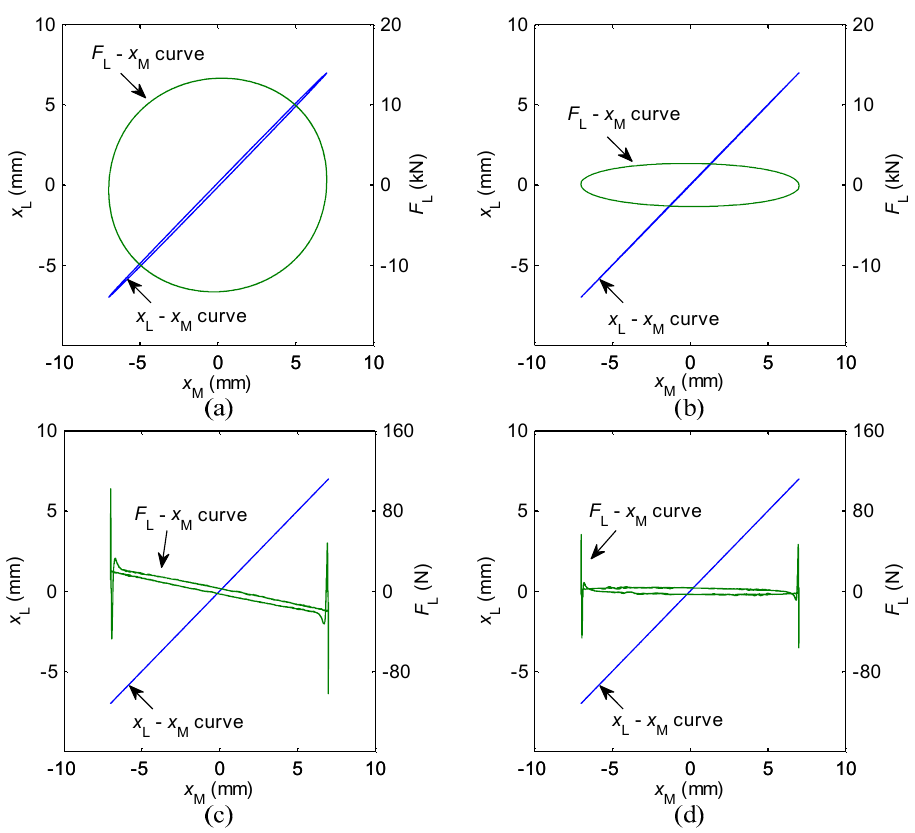
F – x and x – x with disturbance 7sin14 t (mm/s), ( a ) L M L M